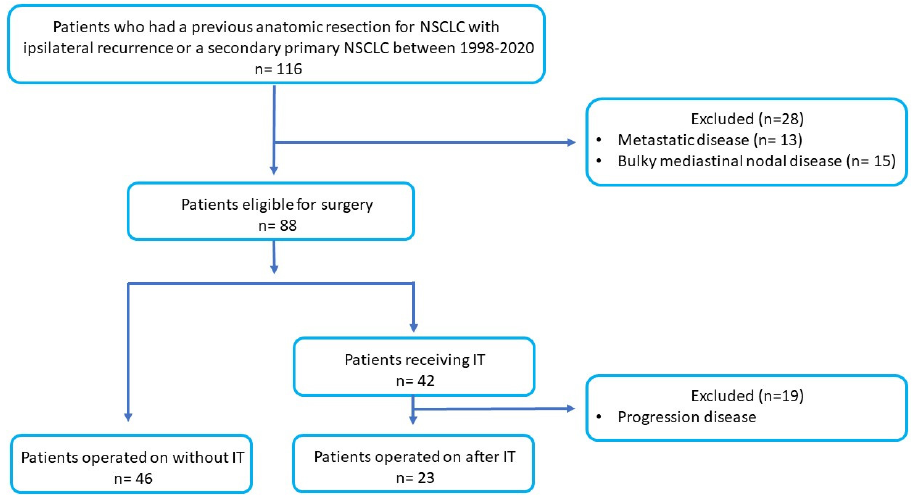
Figure 1. Flow diagram of population with NSCLC selected for this study. IT = induction